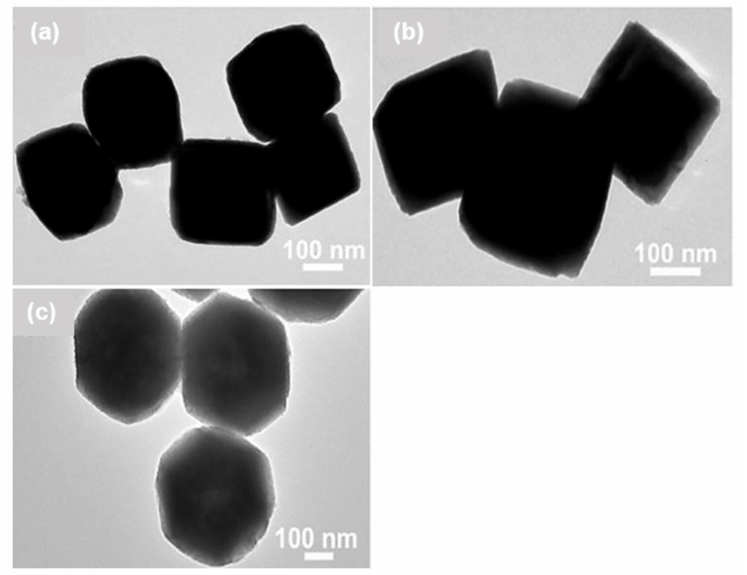
Figure 9. TEM images of: ( a ) Cu 2 O-cube; ( b ) Cu 2 O-octahedron; ( c ) Cu 2 O truncated octahedron, Reprinted from Ref. [140], with the permission of Elsevier Ltd., 2017.